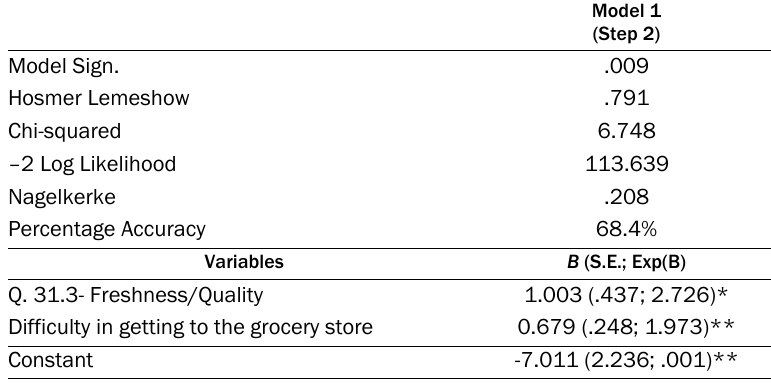
Table 4. Summary Statistics of the Binary Logistic Regression Model in Which Farmers Market Participation Was Regressed on 10 Independent Variables Significant variables and model statistics are